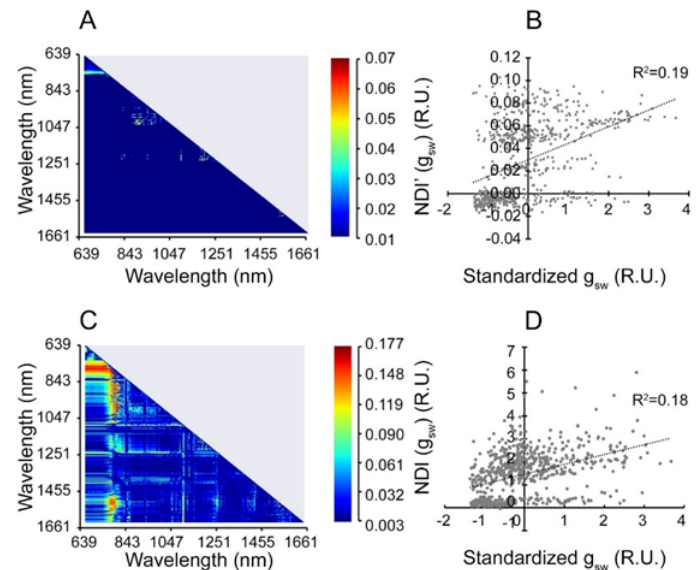
Figure 4. Normalized Differential Spectral Index (NDI) of spectral data collected over the two-year experiment with a cotton plant. ( A ) and ( C ) represent a 53,361 pixelated graph (for 231 x 231 wavelength combinations), where each pixel is colored by the coefficient of determination (r2) as is defined to the right of the graph. Only half of the pixels are shown, as the grey area is their mirror image. ( B ) and ( D ) represent the correlation between the calculated NDI with the maximum R2. Each grey dot represents a stomatal conductance measurement out of the 658 samples of the dataset.